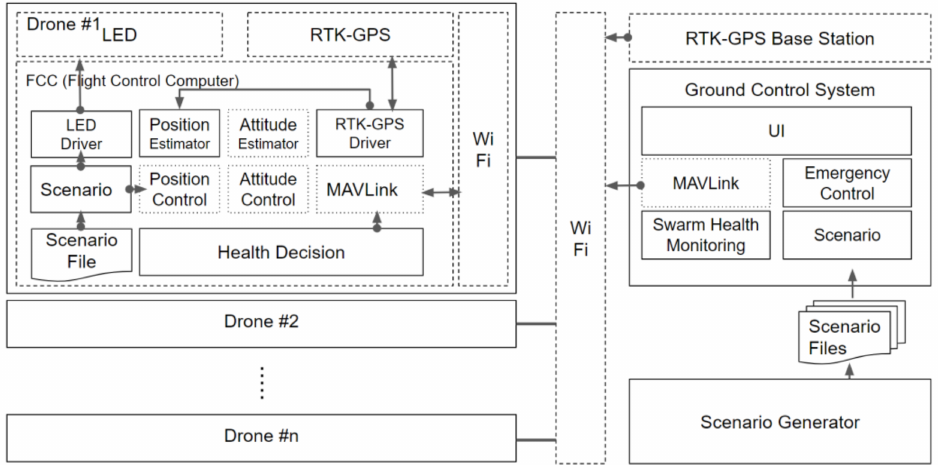
Figure 2. Control architecture for swarming flight (solid box: contributed software component, dotted box: PX4 software component, dashed box: hardware